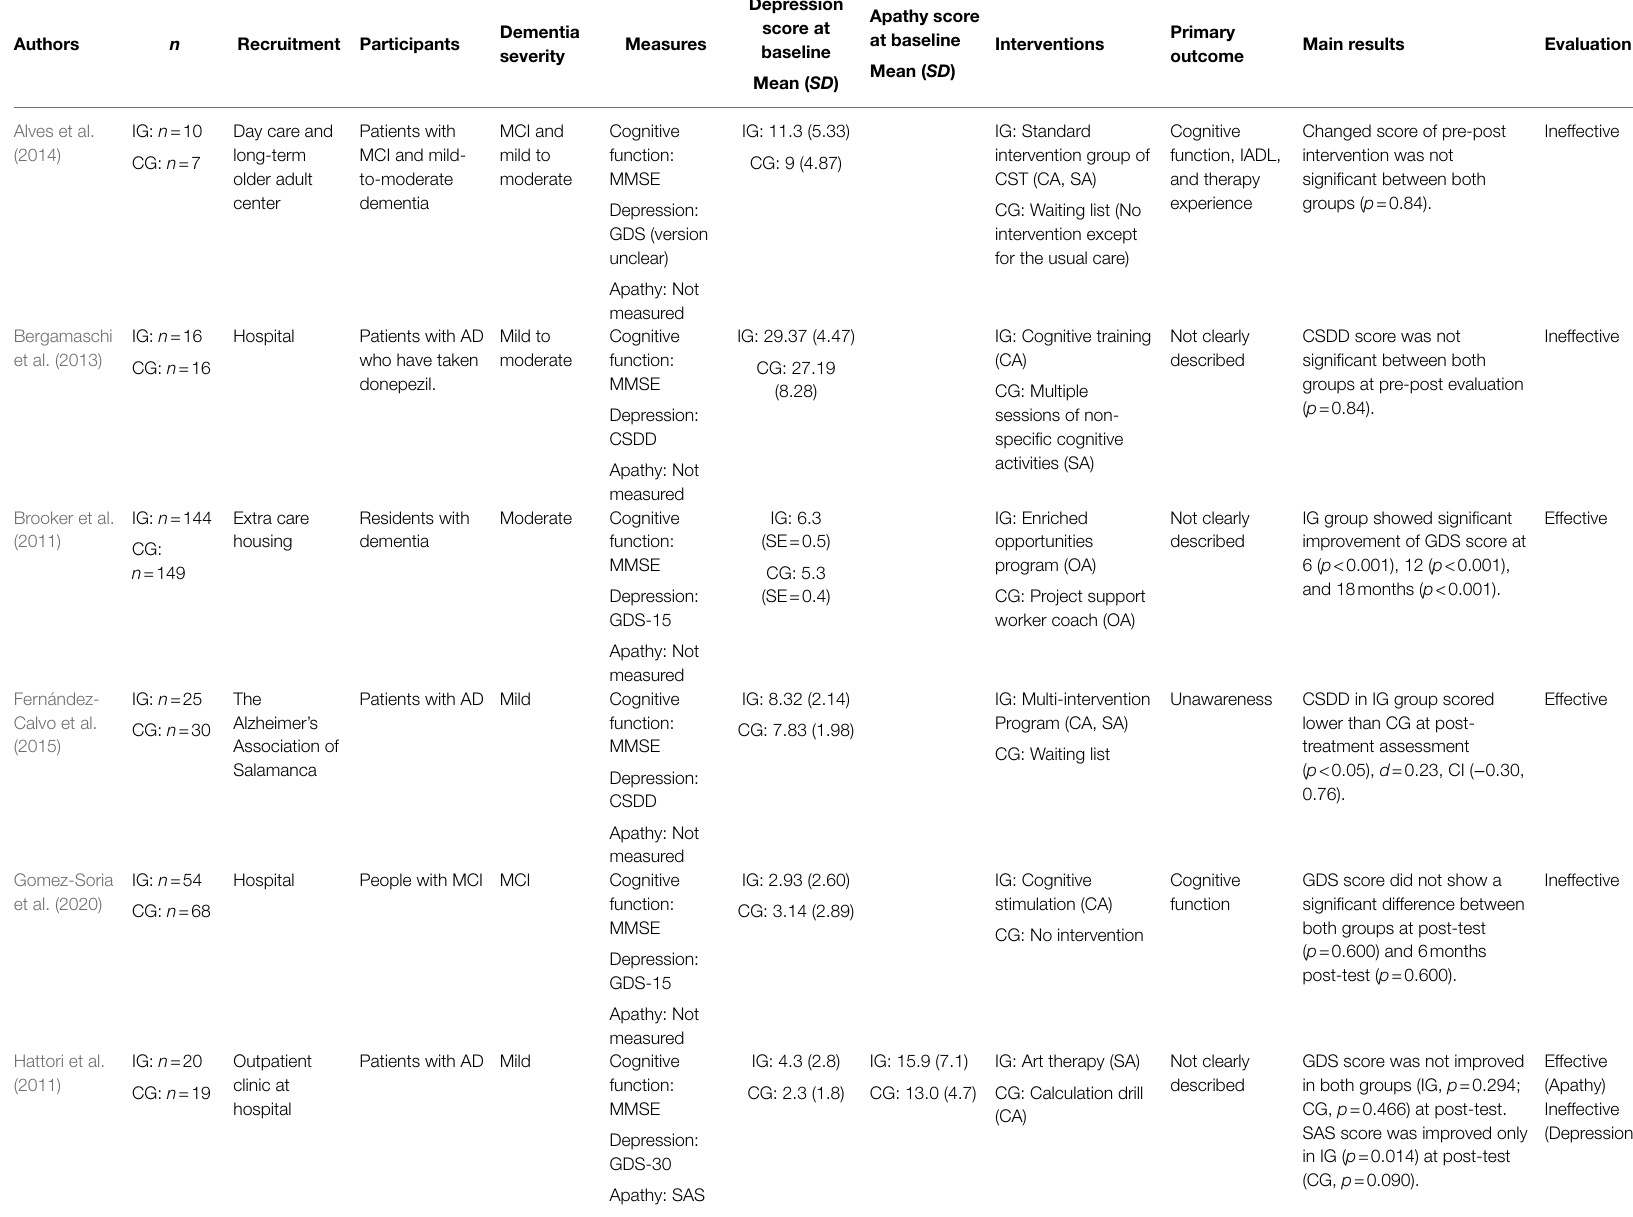
TABLE 1 | Randomized controlled trial of non-pharmacological interventions for apathy and depression. Authors n Recruitment Participants